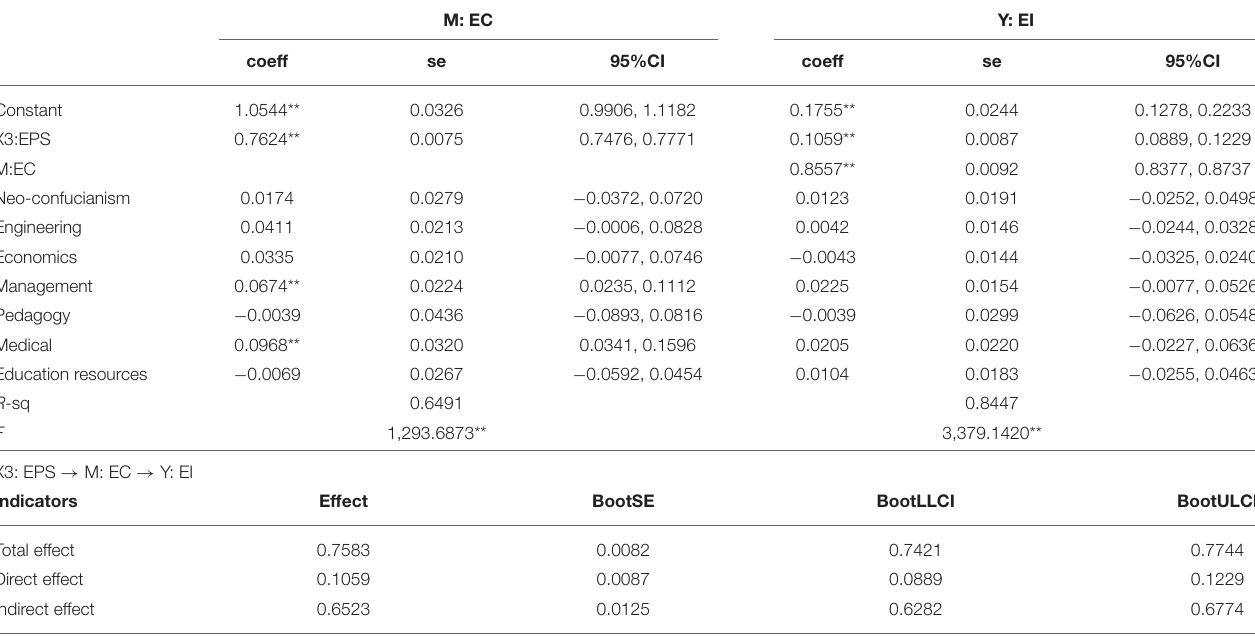
TABLE 6 | Moderated mediating effect analysis with EPS as independent